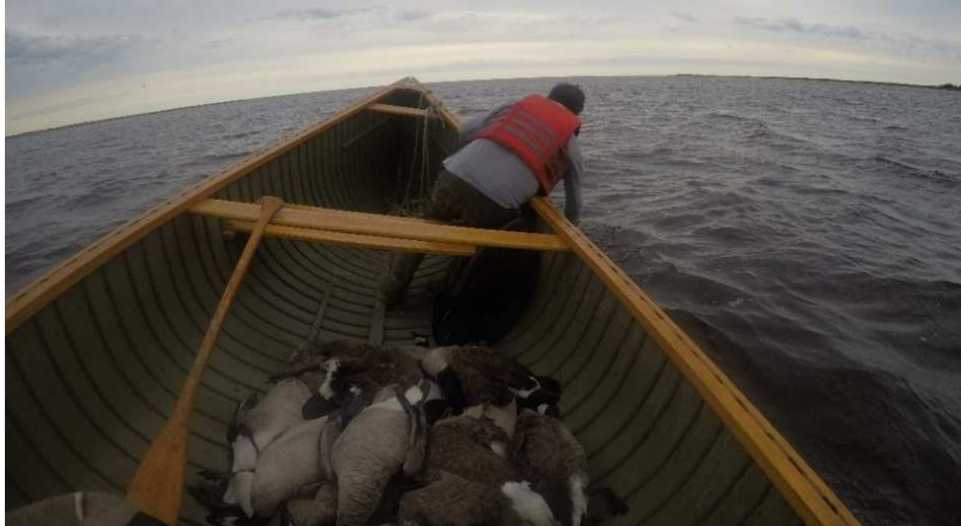
Figure 4. An on-the-land expert pulling a Canada goose from the bay into the canoe.